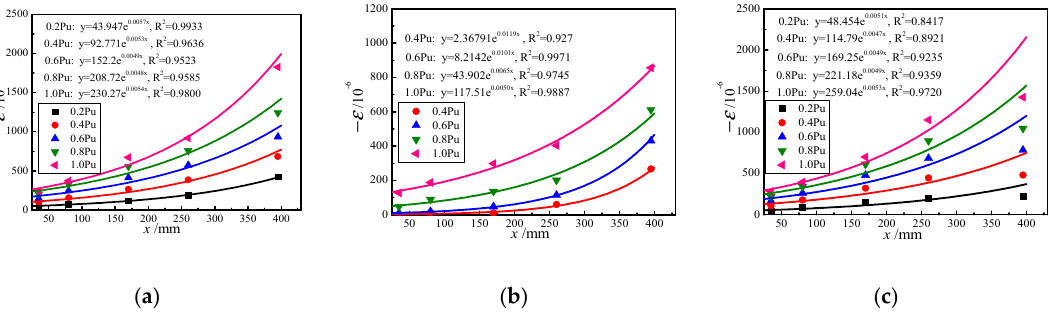
Figure 13. Fitting results of strain distribution along longitudinal direction ( a ) HSCFST-2W; ( b ) HSCFST-7W; ( c ) HSCFST-12W.